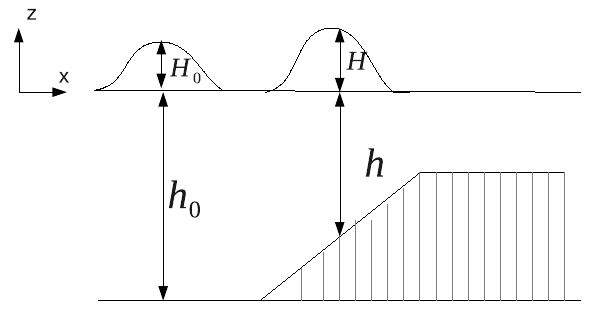
Fig. 1. The geometry of the problem. The waveheight H is mea- sured on the slope. Figure 1: The geometry of the problem. The waveheight H is measured on the slope.